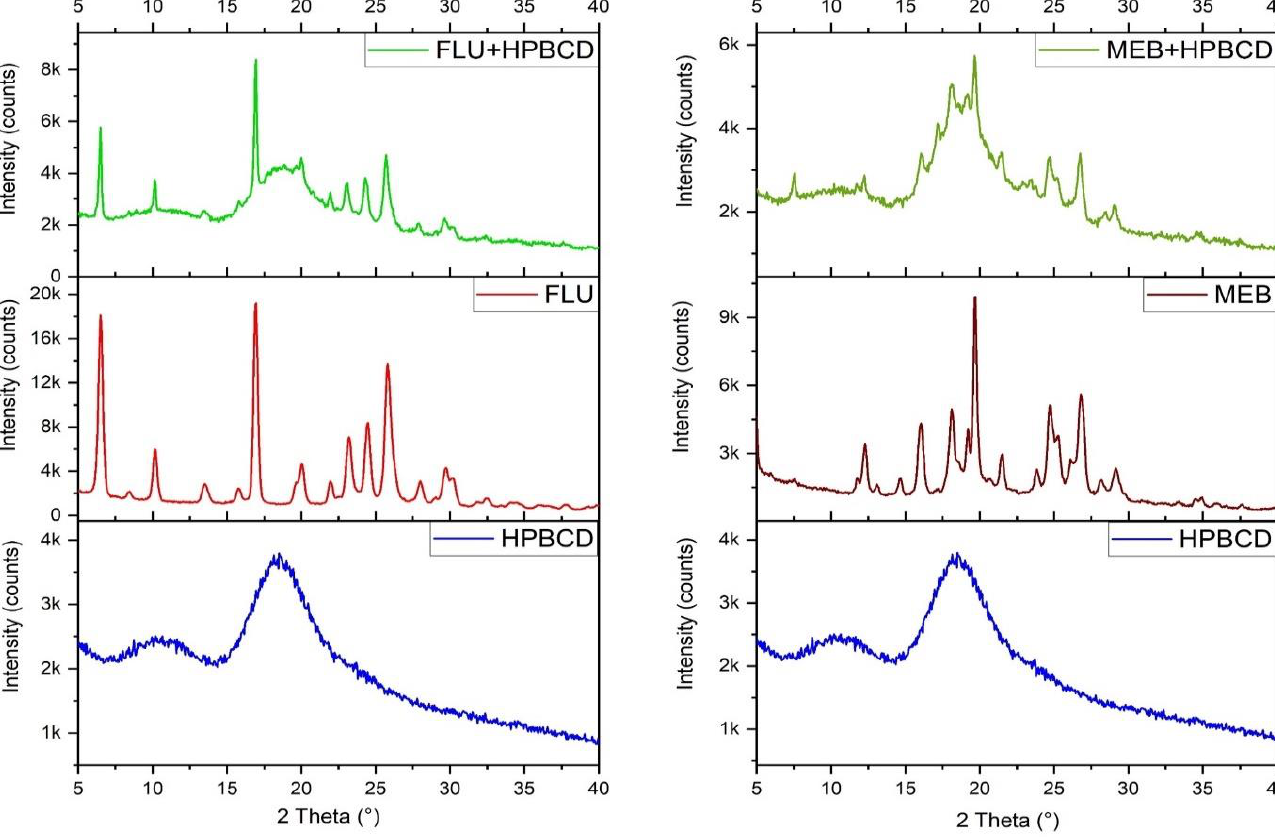
Figure 4. XRD spectra for FLU, MEB, and their physical mixture with HPBCD.